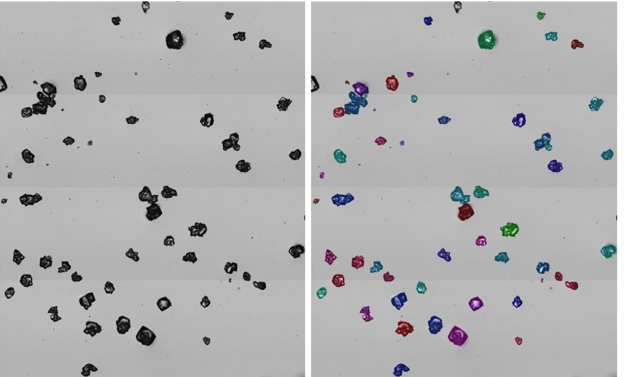
Figure 5. Microscopy pictures of the product from Exp P01 ( left ) and detected particles by image analysis ( right